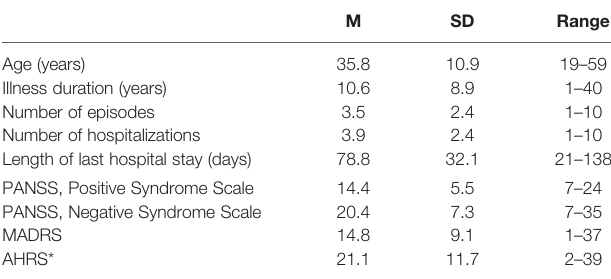
TABLE 3 | Characteristics and symptom severity of the participants (n = 27).